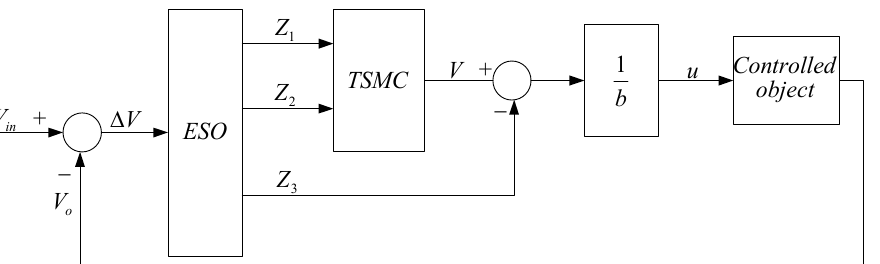
Figure 12. The structure block diagram of terminal sliding mode controller based on extended state observer.